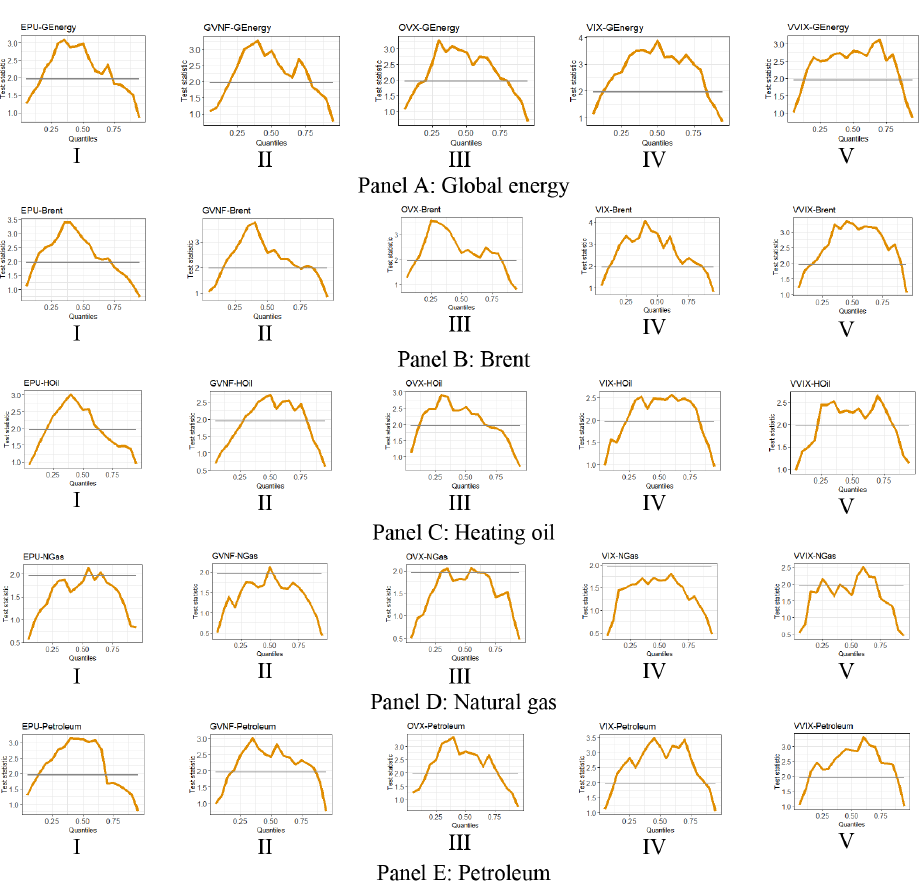
Figure 2. Causality-in-means